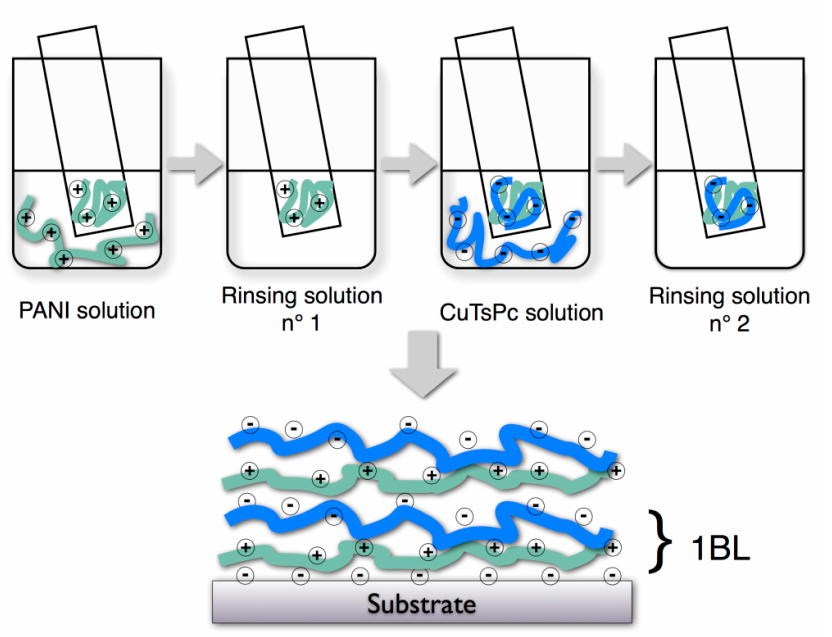
Figure 7. Scheme of the LBL process for PANI/CuTsPc films.